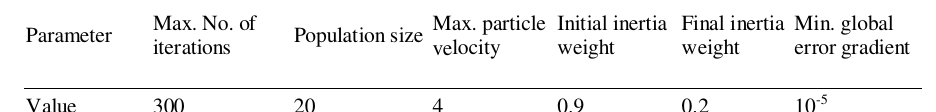
Table 2. Initial values of PSO parameters.